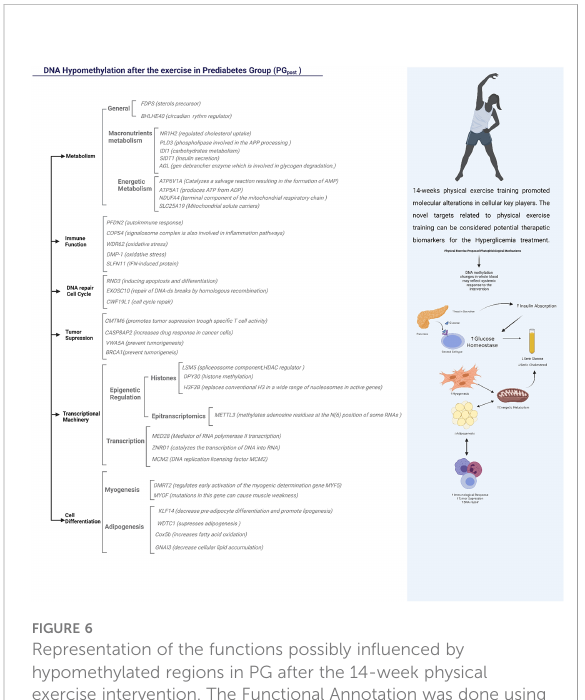
FIGURE 6 Representation of the functions possibly in fl uenced by hypomethylated regions in PG after the 14-week physical exercise intervention. The Functional Annotation was done using the Genecards Database and literature text